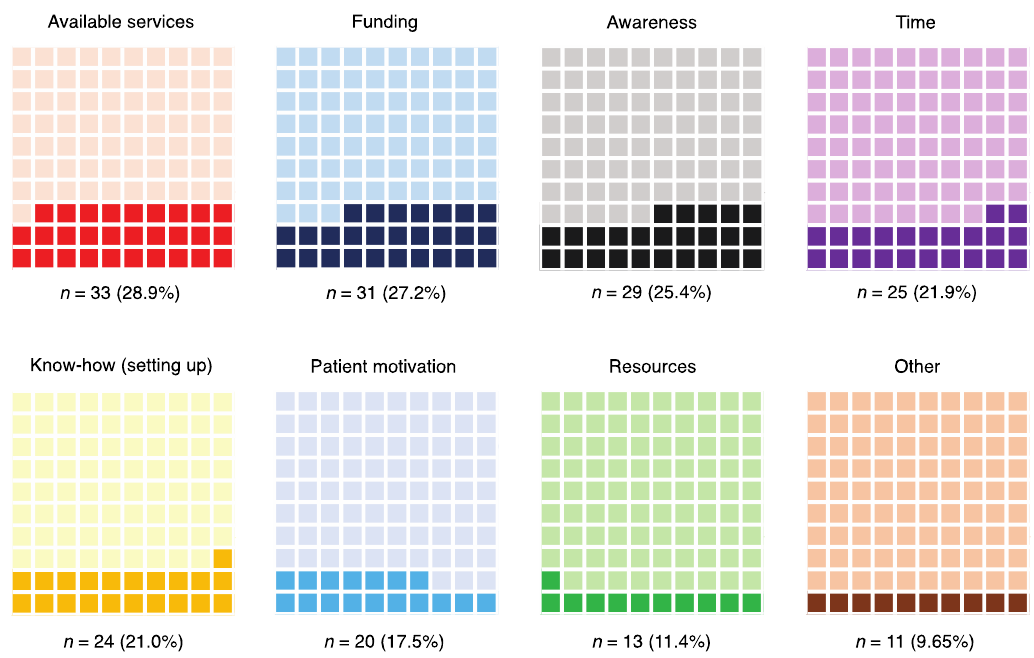
Figure 6. Waffle charts showing what GPs consider to be the key constraints to green prescribing. These charts show proportions with actual response counts and corresponding percentages below. The proportions are presented in descending order (i.e., of response frequency) from top left to bottom right.